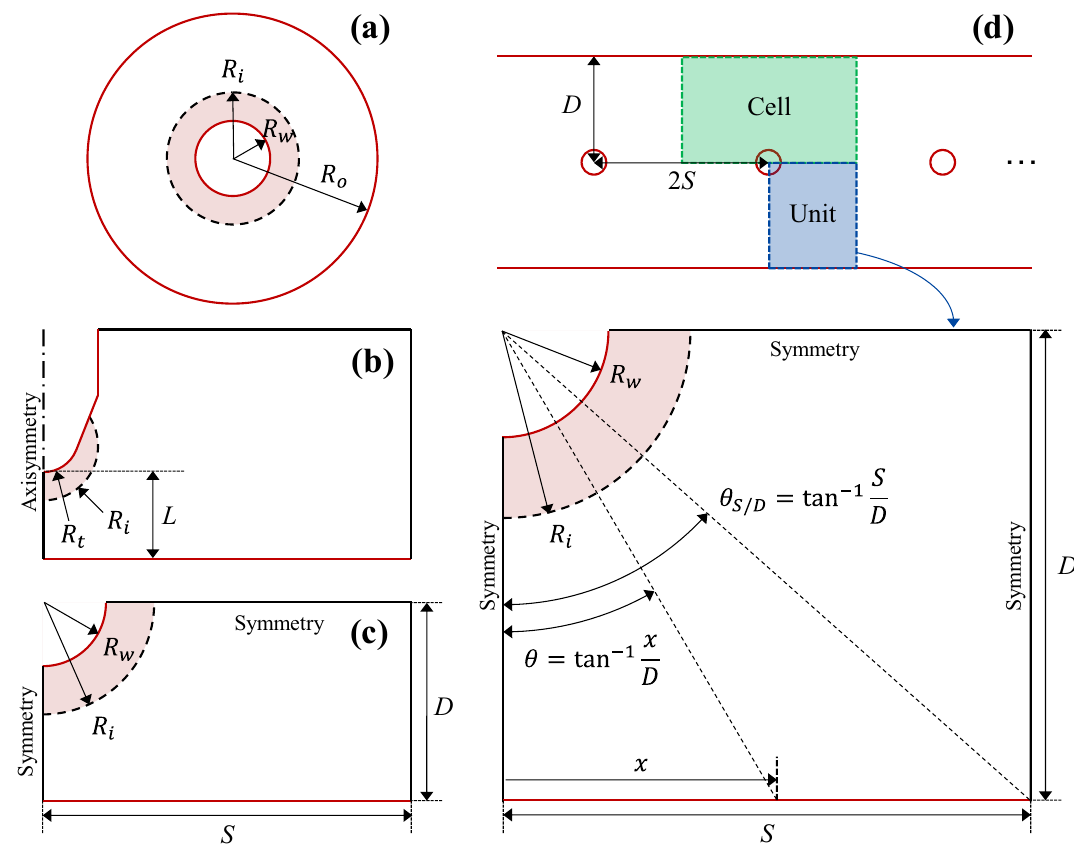
Figure 1. Computational domains and schematic diagrams of the ionization region: a coaxial cylinders, b pin- to-plane, c single wire-to-plane, and d multiple wire-to-plane configurations.